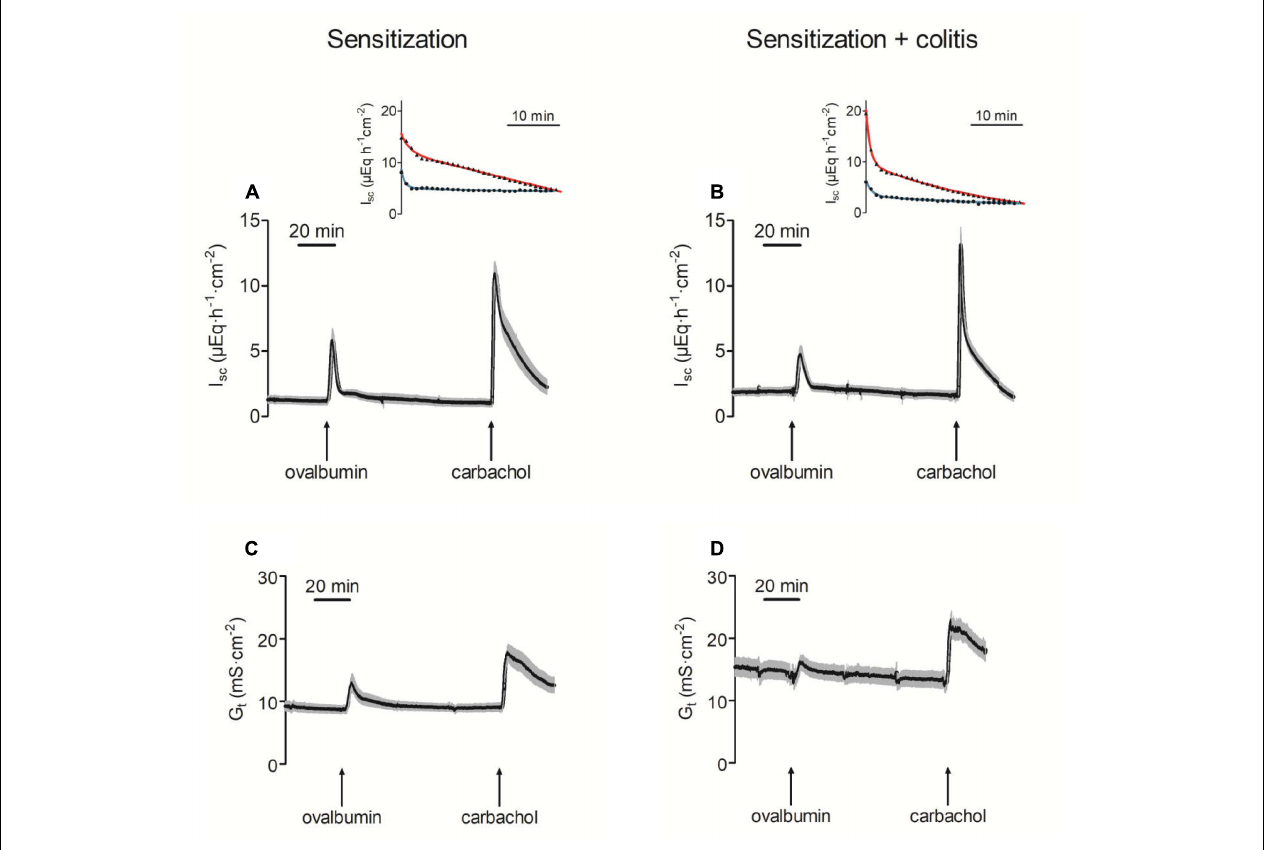
FIGURE 2 | Increase of short-circuit current (I sc ; A,B ) and tissue conductance (G t ; C,D ) in distal colon after administration of ovalbumin (100 µ g · ml − 1 at mucosal and serosal side) in animals sensitized against ovalbumin without (A,C) or with additional induction of a colitis with TNBS/ethanol (B,D) . The final administration of carbachol (5 · 10 - 5 M at serosal side) served as viability control. Values are means (black area) ± SEM (gray area), n = 8–11. The insets show a representative original tracing of the decay of the carbachol-induced I sc in each experimental group (red line = distal colon; blue line = jejunum). Black points in the insets are typical I sc traces from individual tissue (reduced to one data point every minute for graphical clarity). The colored lines show the fit to an exponential function (for time constants and statistics, see Table 4 ).